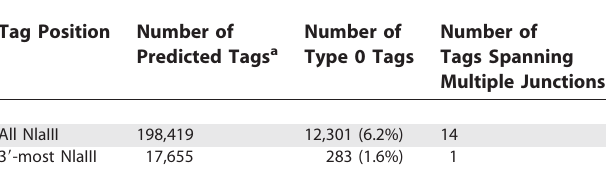
Table 1. A Total of 6.2% of Predicted Tags from All NlaIII Restriction Sites and 1.6% from 3 9 -Most Sites Were Found